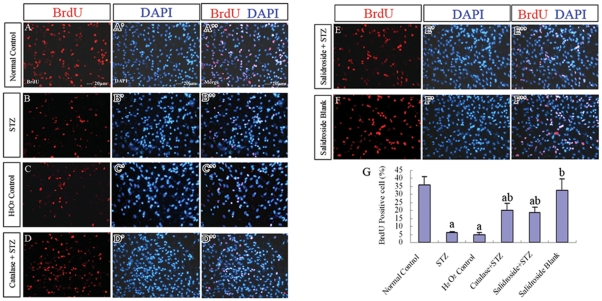
BrdU labeling in NSCs.NSCs at P2 were labeled with BrdU (10 µM) for 4 h×3 times (three times each for 4 hours), and then immunofluorescently stained for BrdU. (A–F, A′–F′, A″–F″) Representative photomicrographs of BrdU labeled cells (red, A–F) with their nuclei counterstained by the nuclear fluorescent stain DAPI (blue, A′–F′) in six experimental groups: (A-A″) Normal control group, (B-B″) STZ group, (C-C″) H2O2 control group, (D-D″) Catalase+STZ group, (E-E″) Salidroside+STZ group and (F-F″) Salidroside blank group. (G) Bar chart showing the percentages of BrdU labeled cells. Values are expressed as mean±SD. a
p<0.05 compared with the normal control group; b
p<0.05 compared with the STZ group.